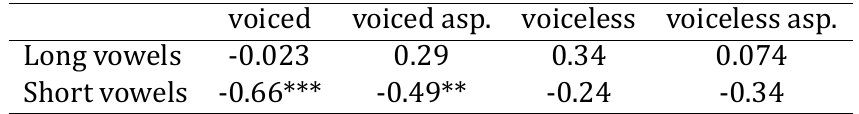
Table 10: Correlations between Telugu vowel duration and total stop duration (closure + aspiration). N was approximately 17 in each group, with some variation due to errors and excrescent (cid:976)inal